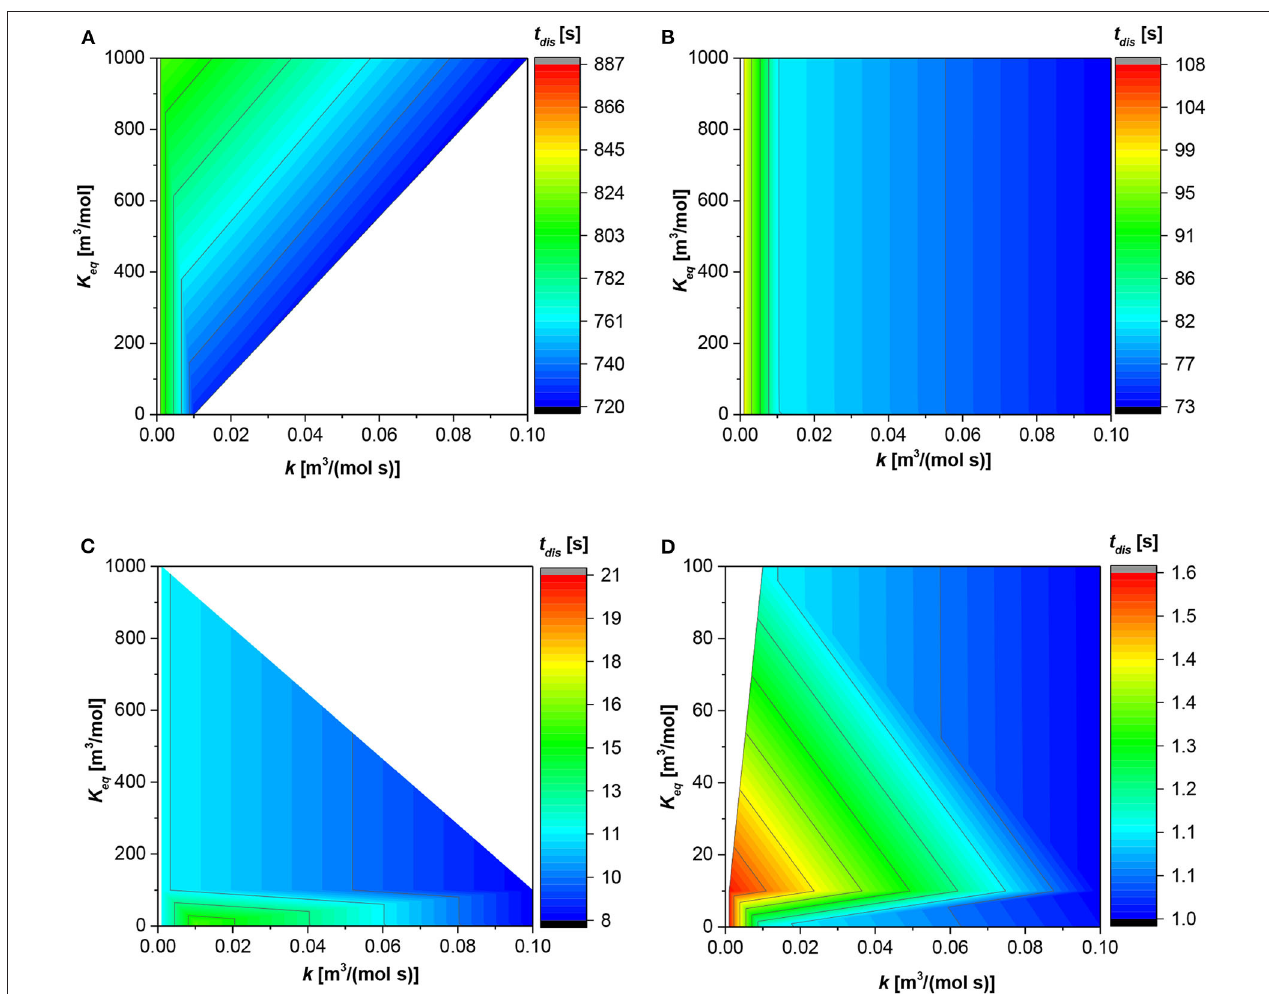
FIGURE 2 | Contour plot for the dissolution time ( t dis ) along the reaction and equilibrium constant. (A) First dimensionless number ( AD 1 ) = 1 × 10 − 3 [-]; (B) AD 1 = 1 × 10 − 2 [-]; (C) AD 1 = 1 × 10 − 1 [-]; (D) AD 1 = 1 [-].